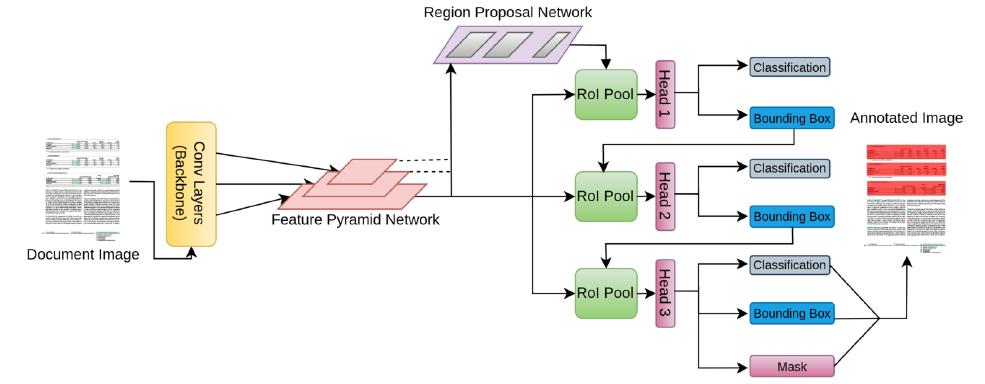
Figure 6. The detection pipeline for the Cascade Mask R-CNN detection head. Cascade Mask R-CNN has multiple heads and utilizes cascading among these heads to refine the bounding box